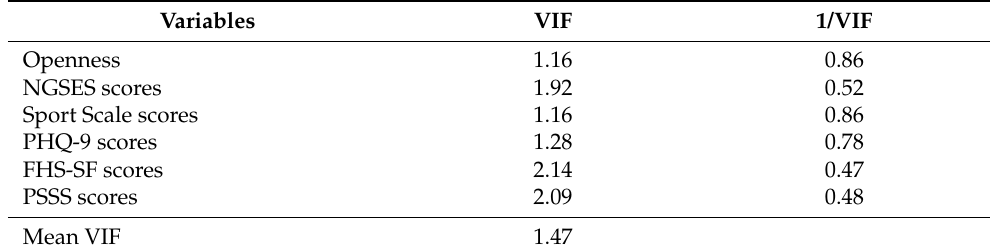
Table A4. The variance inflation factor of variables in stepwise regression analysis. Variables